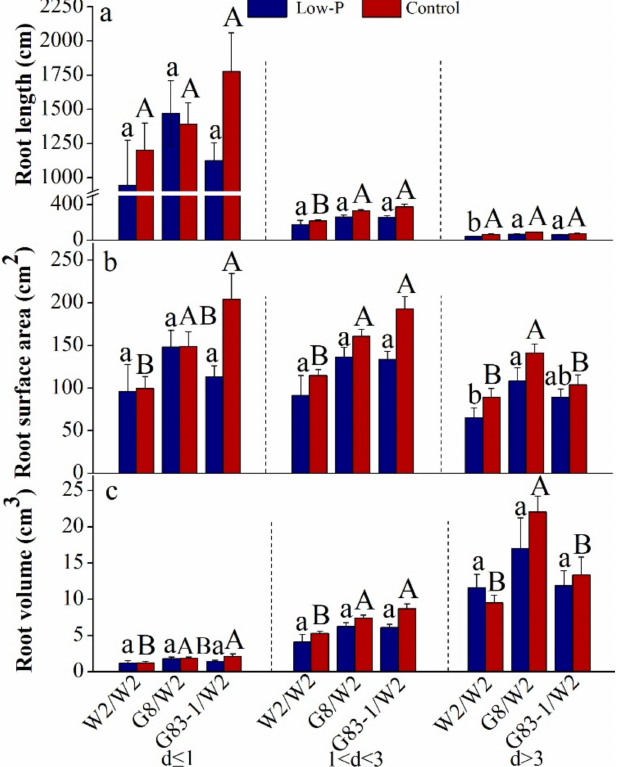
Figure 3. Root length ( a ), root surface area ( b ), root volume ( c ) of the scion (W2, G8, and G83-1) grafted onto W2 rootstock under control (0.5 mM) and low-P (0 mM) conditions during eight months. Lowercase and uppercase indicate significant differences among grafted combination under controls and the low-P supply treatments, respectively ( p ≤